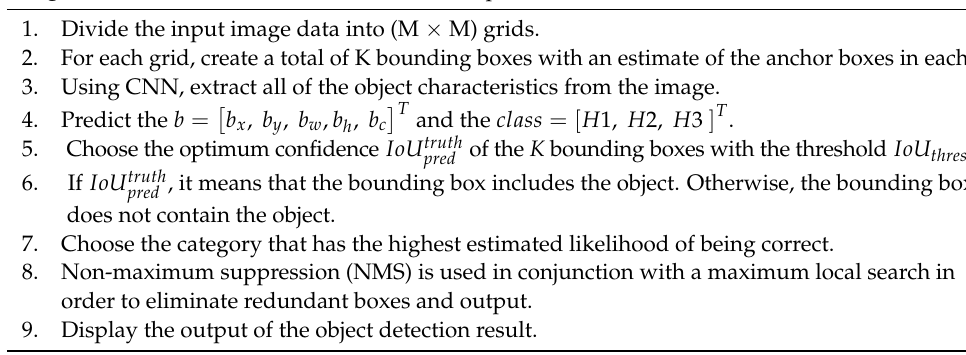
Algorithm 1. Yolo V4 CSP SPP hand detection